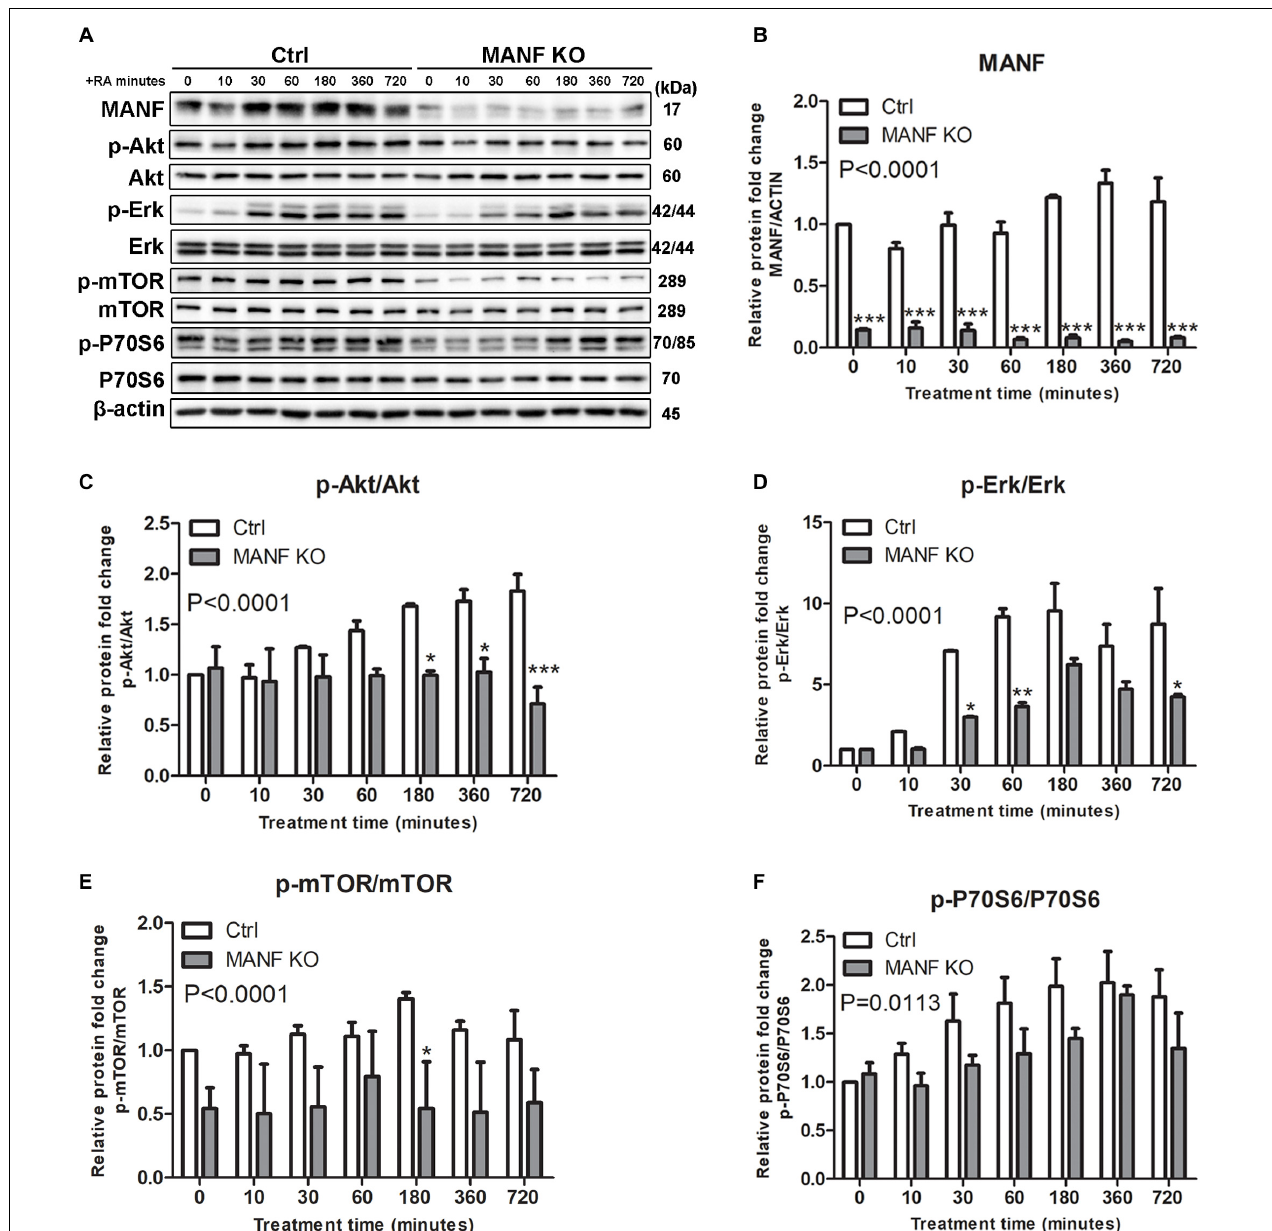
FIGURE 6 | MANF knockout reduces RA-induced activation of Akt/mTOR and Erk/mTOR signaling pathways. (A) Control and MANF KO cells were treated with RA for 10, 30, 60, 180, 360, and 720 min. Protein was extracted from cell lysates and subjected to immunoblot. The size of the proteins (kDa) was labeled next to each band. (B) MANF protein levels were quantified and normalized with β -actin. (C) p-Akt protein levels were quantified and normalized with total Akt. (D) p-Erk protein levels were quantified and normalized with total Erk. (E) p-mTOR protein levels were quantified and normalized with total mTOR. (F) p-P70S6 protein levels were quantified and normalized with total P70S6. The data were expressed as the mean ± SEM of three independent experiments and were analyzed by Two-way ANOVA followed with the Bonferroni’s post hoc test, * P < 0.05, ** P < 0.01, *** P <